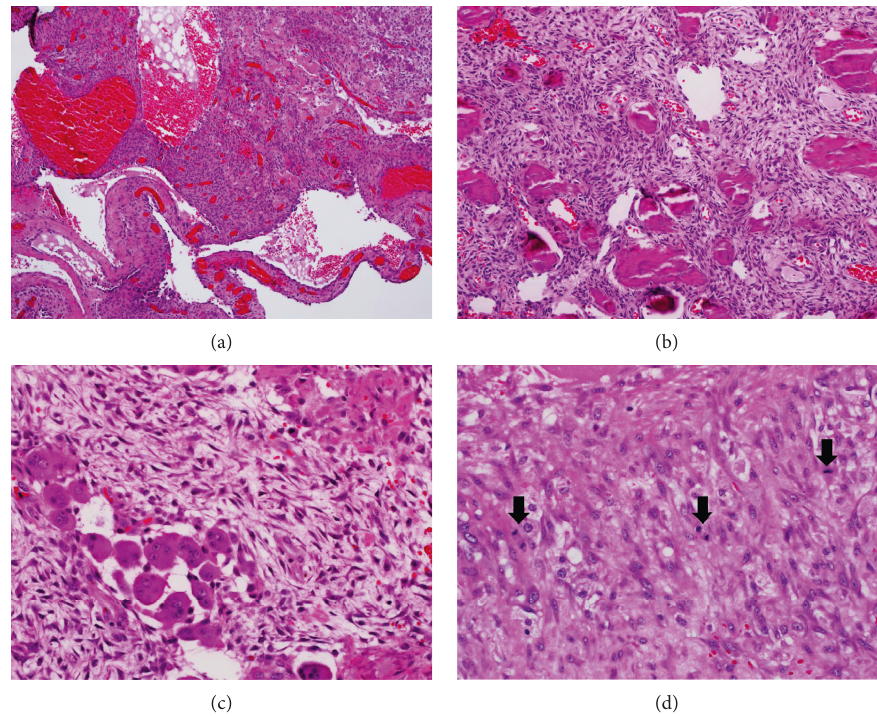
Figure 2: Histopathology examination by hematoxylin and eosin stain (H&E). (a) Tumor is composed of spaces separated by septa (blood- filled cavities) (H&E; 4x). (b) Spindle cell proliferation with classification and osteoid formation (H&E; 10x). (c) Cellular components with osteoclast-like giant cells (H&E; 40x). (d) Numerous mitotic figures are seen (arrow head) (H&E;